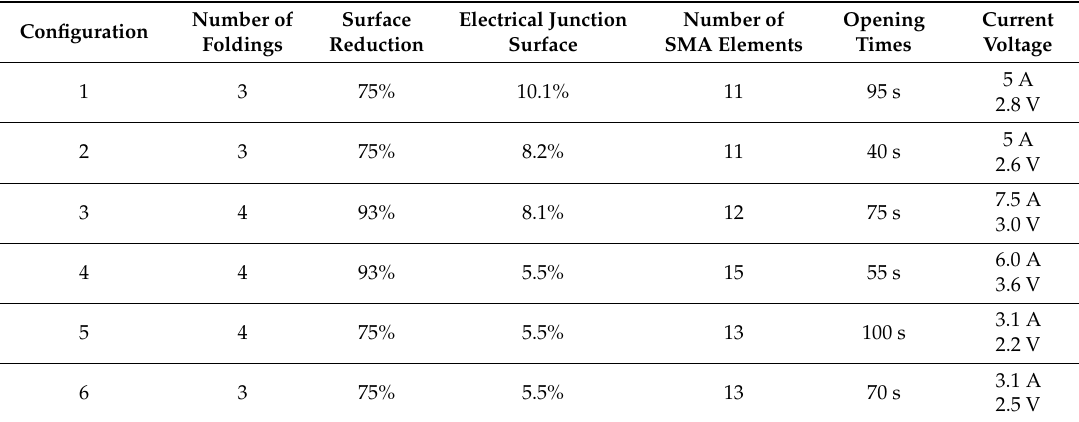
Table 1. Main features of the di ff erent sail